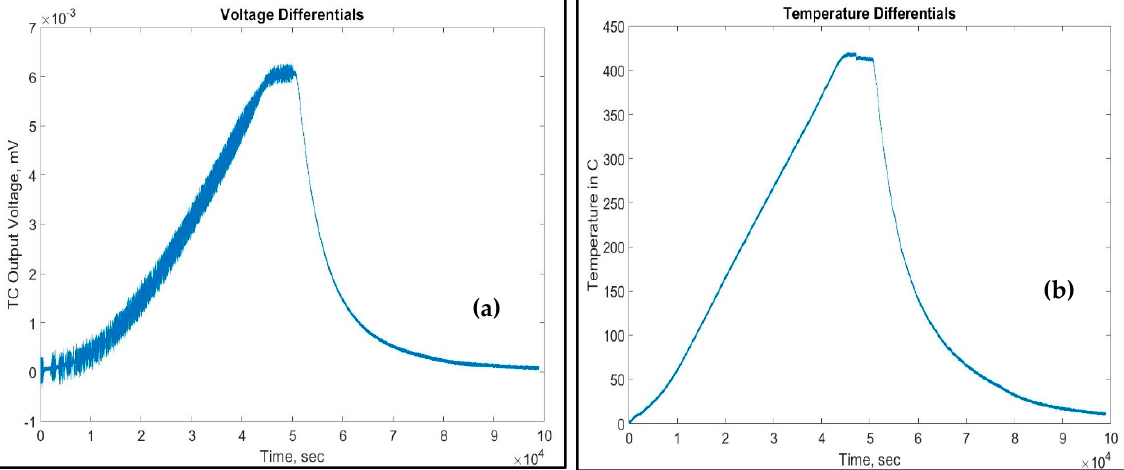
Figure 5. Cycling plots for ( a ) voltage differentials and ( b ) the temperature differentials for PG-Al